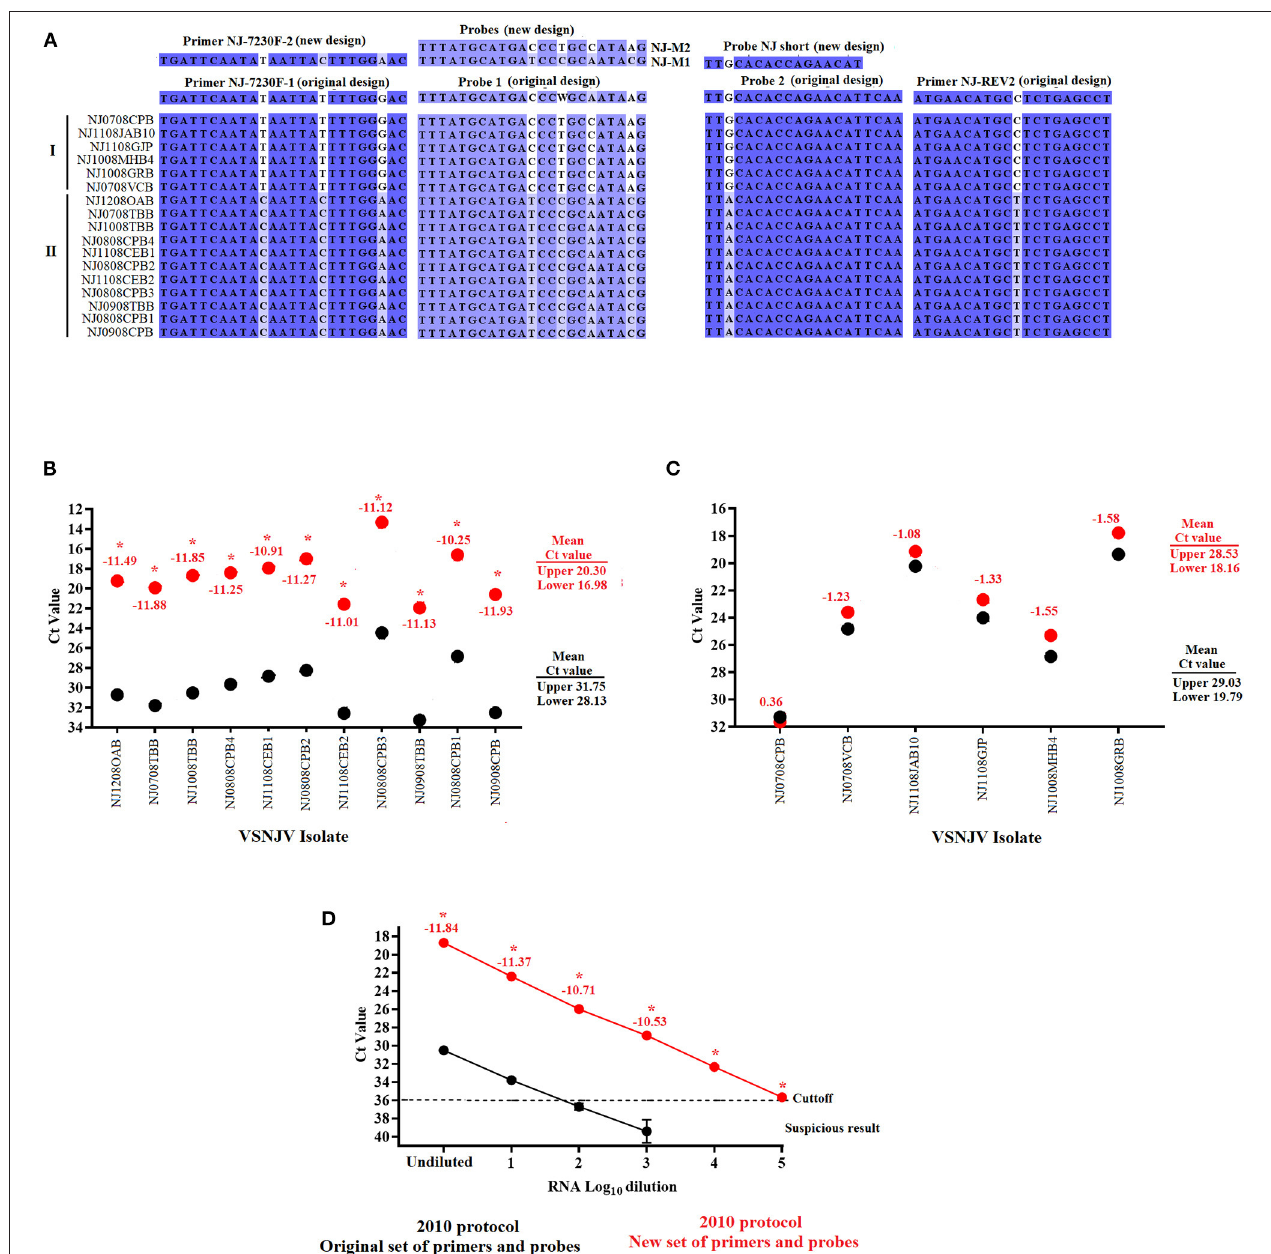
FIGURE 2 | Development and validation of the new set of primers and probes for the VSVNJ component. (A) Detection of mutations associated with viruses from lineage 2.1 in the target region of the L gene. The sequence of new primers and probes designed to update the 2010 protocol are shown. The performance of the 2010 protocol using either the original or with a combination between some of the original and the new designed primerson (B) 11 samples from Central American lineage 2.1, and (C) 6 samples representing 1.1, 1.2 and endemic lineages from Mexico. (D) Comparison in the analytical sensitivity between the two versions of the 2010 using several 10-fold dilutions of RNA extraction from a representative virus of lineage 2.1.Upper and lower means were calculated using JMP PRO software with the standard error set at p < 0.05. Numbers under different symbols represents the differences in the Ct values between samples evaluated by the two versions of the 2010 protocol. Asterisks represent statistically significant values ( p < 0.05) obtained by the paired T -test conducted in GraphPad 9.0.0; symbols represent the average of three replicates.